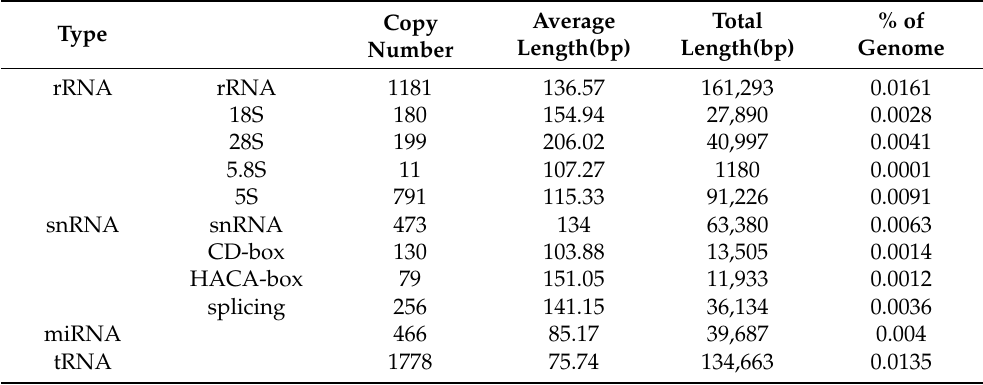
Table 3. Summary statistics of noncoding RNA in E. cyanopodus